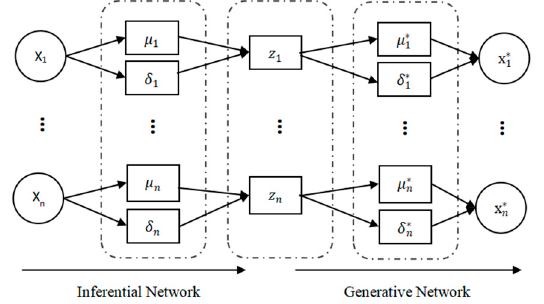
Figure 3. VAE structure. * represent variables in the Generation Network in Figure. VAE uses KL divergence to measure the similarity between q φ ( z | x ) and true posterior distribution p θ ( z | x ) and minimizes KL divergence by optimizing constraint parameters θ (generative network parameters) and φ (inferential network